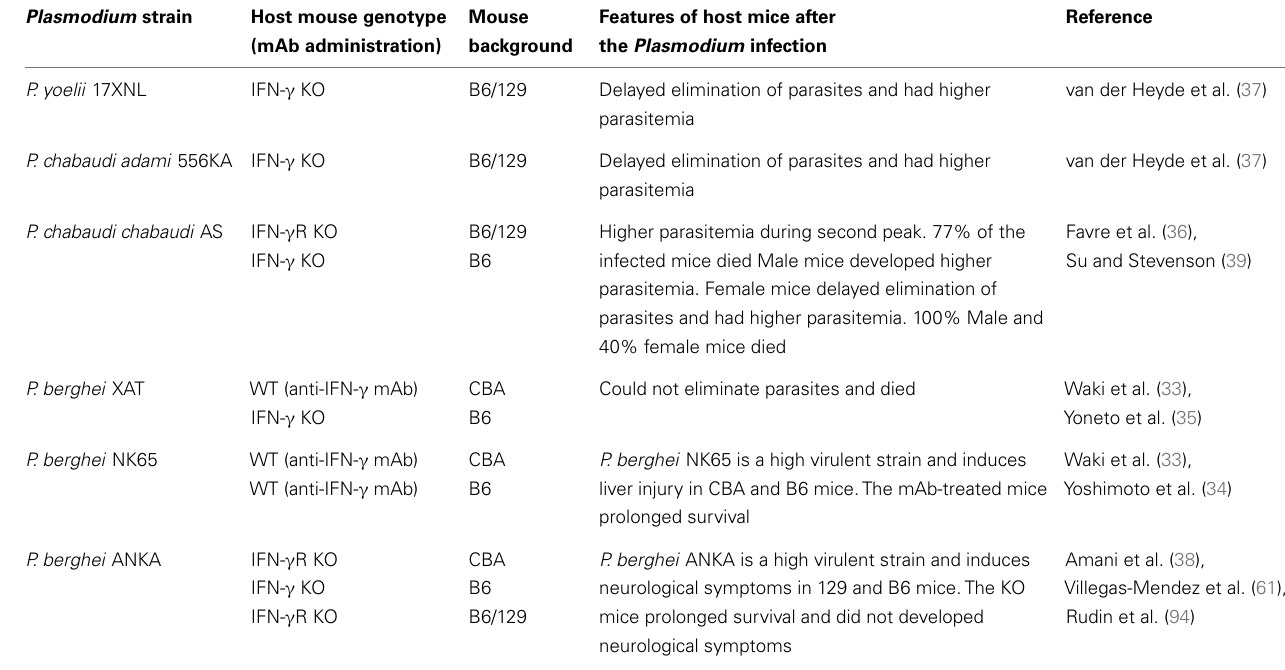
Table 1 | Influence of IFN- γ -signal deficiency on control of Plasmodium parasites in mice. Plasmodium